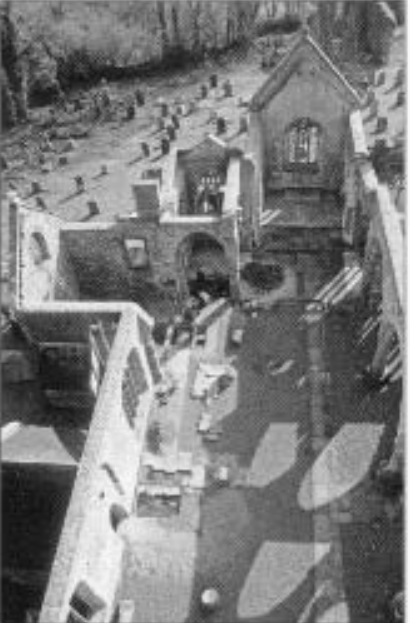
Figure 4 The ruined interior of Holy Trinity church looking east from the restored tower and showing trenches A, B and C under excavation, April